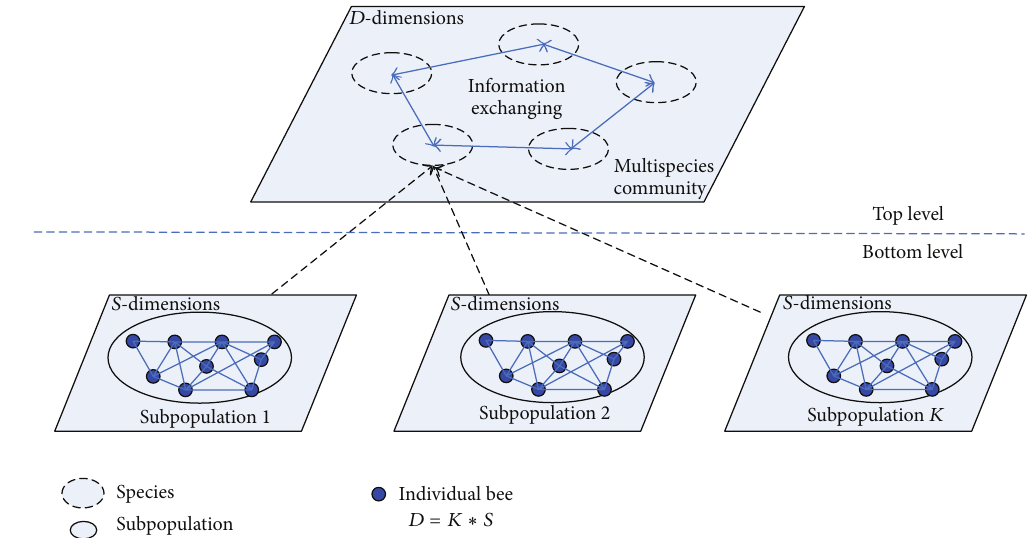
Figure 1: Hierarchical optimization